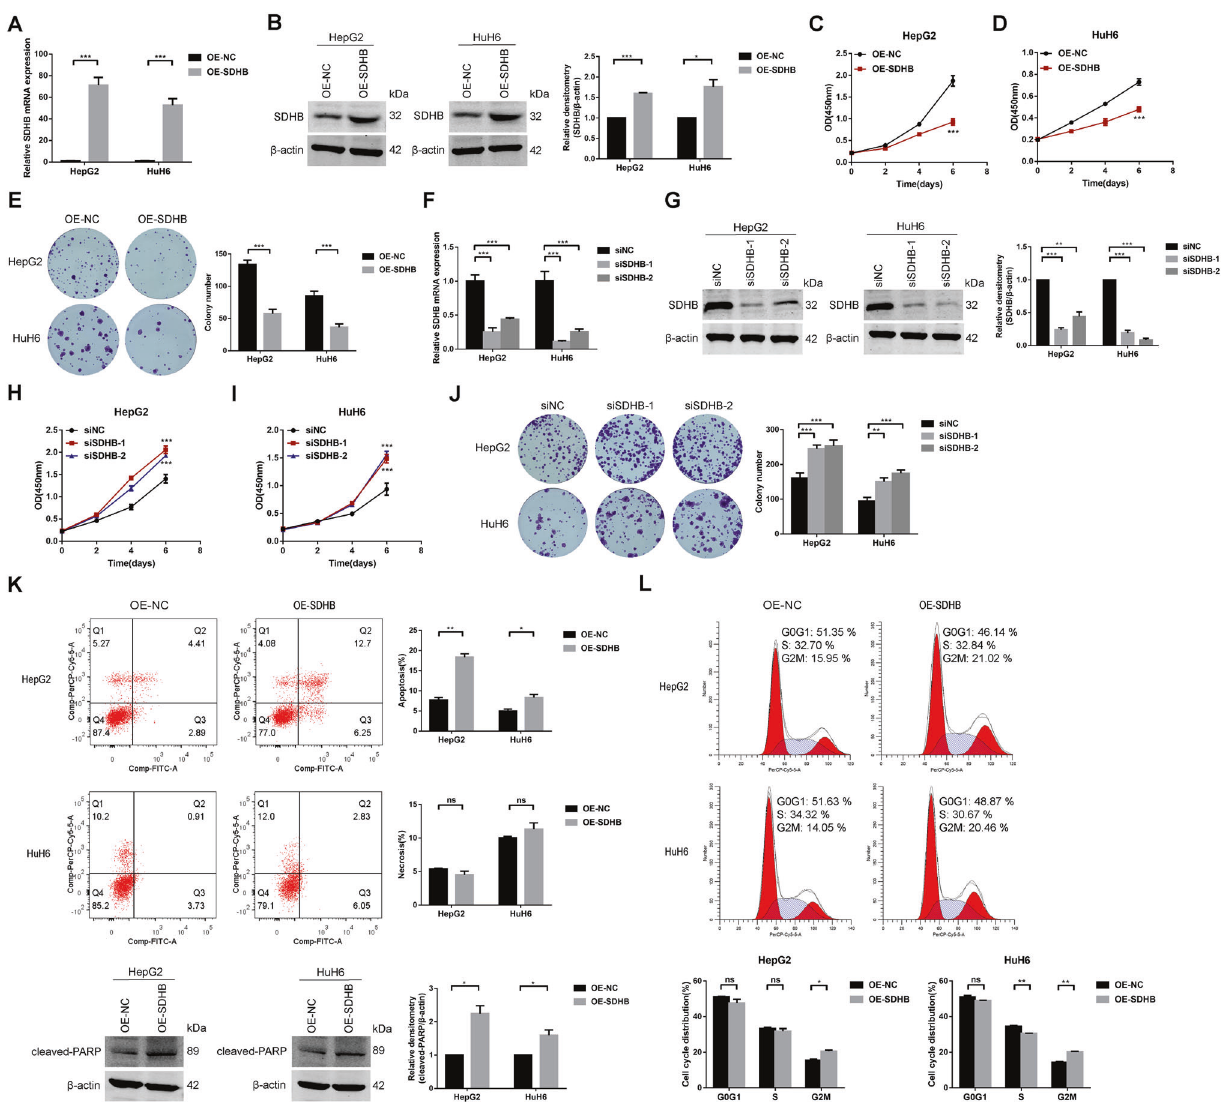
Fig. 7 SDHB overexpression inhibits HB cell proliferation, promotes cell apoptosis and arrests cells in the G2/M phase. A , B The mRNA ( A ) and protein ( B ) levels of SDHB in HB cells transfected with OE-NC or OE-SDHB plasmids were measured by qRT ‒ PCR and Western blotting assays. Relative densitometry was performed with ImageJ. C – E The proliferative activity of treated HB cells was detected by CCK-8 ( C , D ) and colony formation ( E ) assays. F , G The mRNA ( F ) and protein ( G ) levels of SDHB in HB cells transfected with siNC or siSDHB-1/-2 were measured by qRT ‒ PCR and Western blotting assays. Relative densitometry was performed with ImageJ. H – J The proliferative activity of treated HB cells was detected by CCK-8 ( H , I ) and colony formation ( J ) assays. K The apoptosis/necrosis and cleaved PARP protein levels of treated HB cells were detected by fl ow cytometry and Western blotting assays, respectively. Relative densitometry was performed with ImageJ. L The cell cycle of treated HB cells was detected by fl ow cytometry